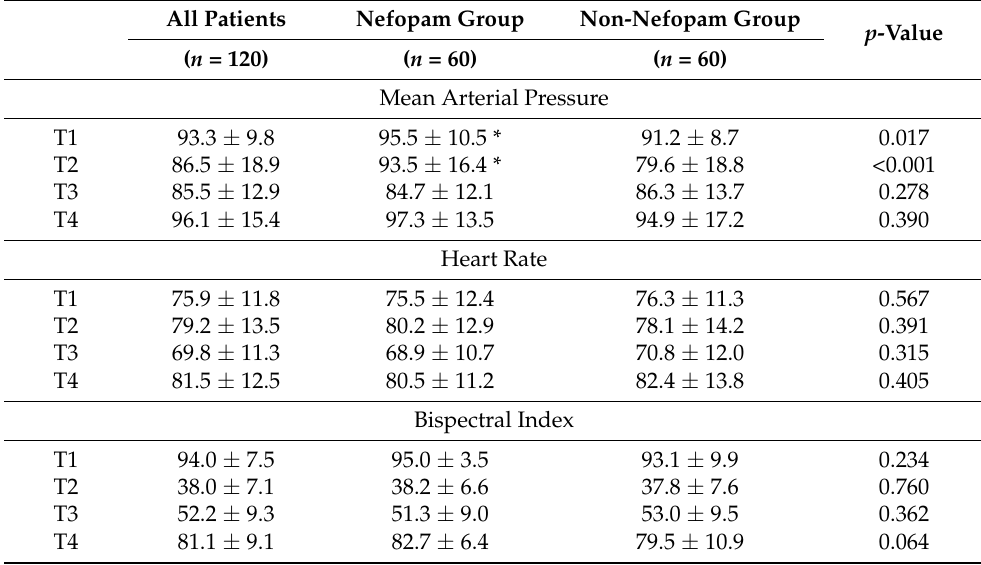
Table 2. Intraoperative vital signs and bispectral index (BIS) values over